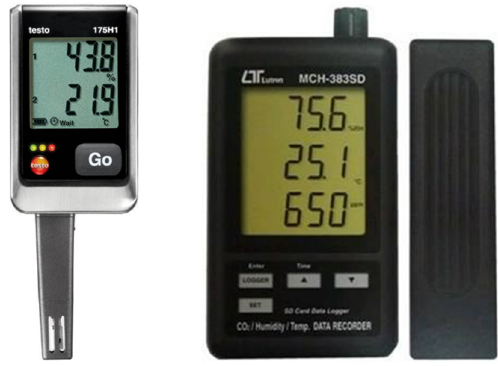
Figure 5. Recording instruments for temperature and RH (Testo 175H1) and CO 2 (MCH-383SD). Table 1. Summary of instrument range and accuracy.